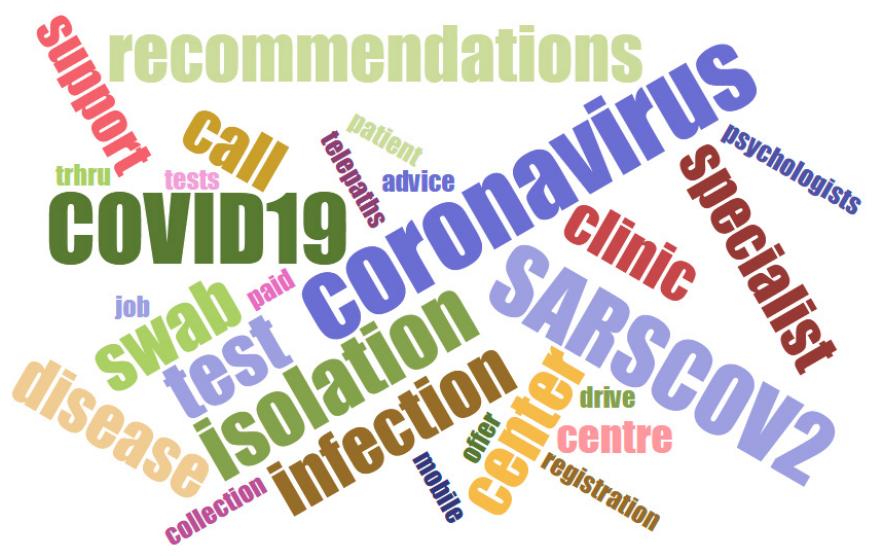
Figure 5. Word cloud–the frequency of selected keywords related to the COVID-19 pandemic on websites of infectious disease hospitals in Poland.